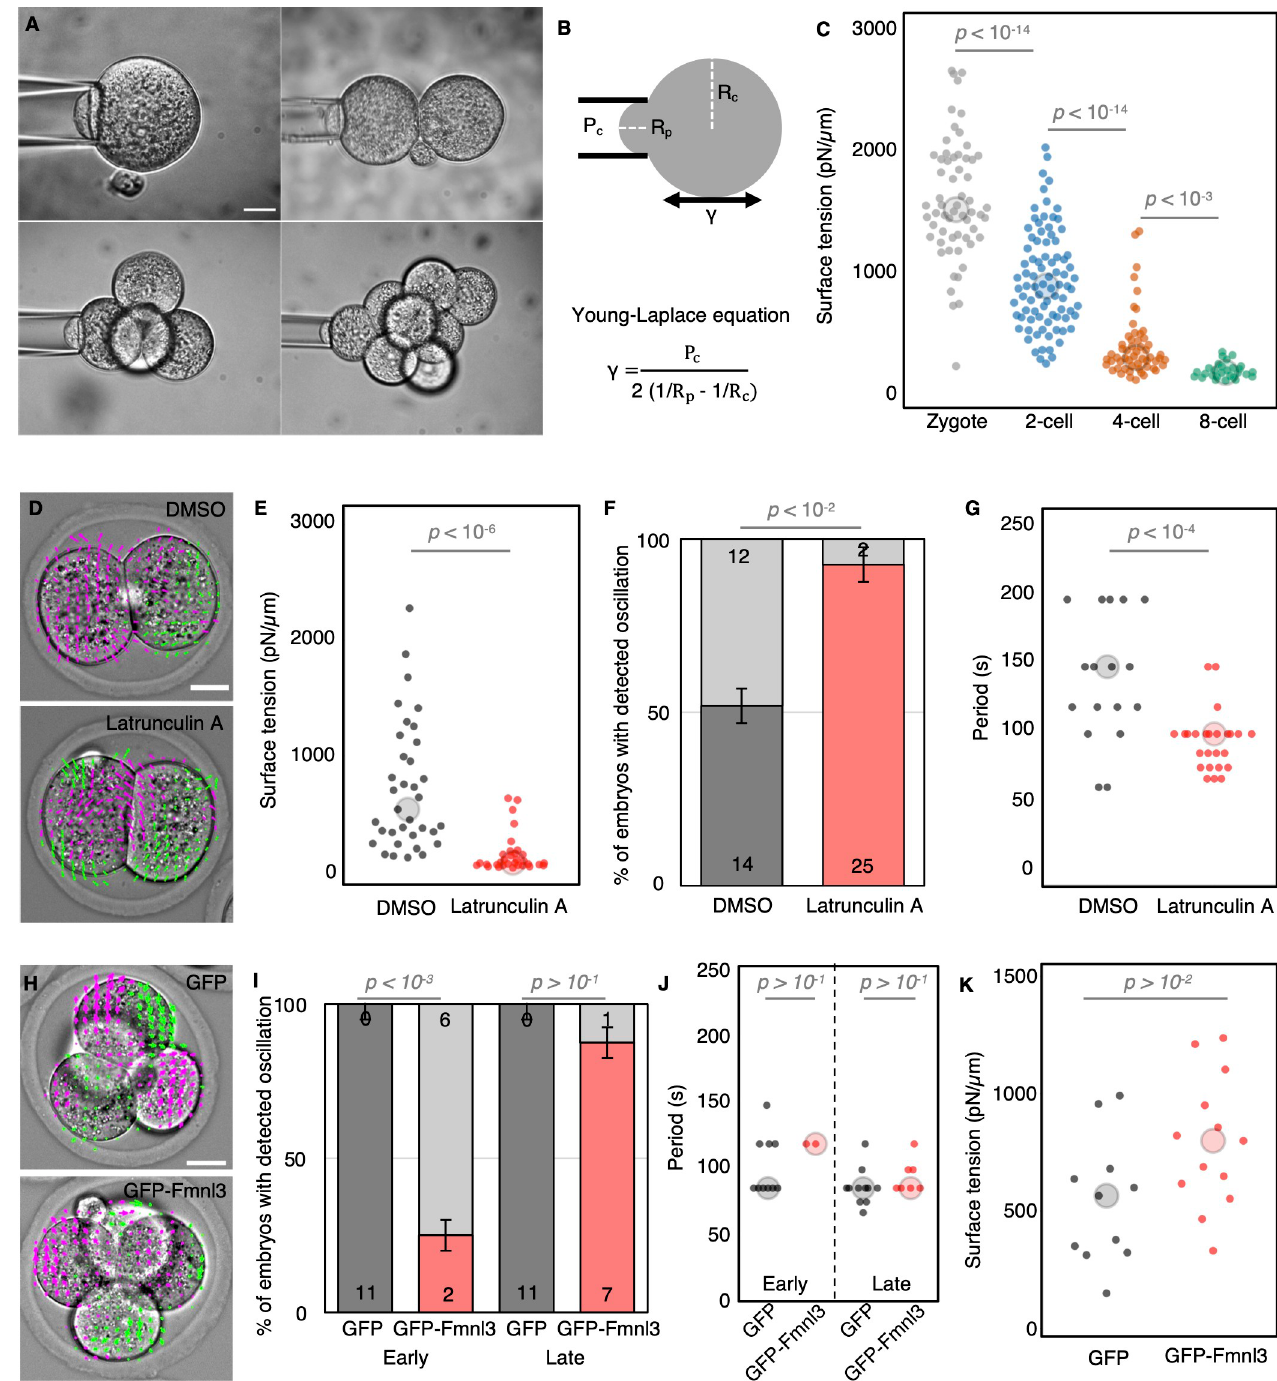
Fig 4. Cortical softening elicits PeCoWaCo. (A) Representative images of tension measurements at the zygote, 2-, 4-, and 8-cell stages. Scale bar, 20 μ m. (B) Schematic diagram of the surface tension measurements. Using the Young–Laplace equation, the surface tension γ can be calculated from the critical pressure P c applied by a micropipette of radius R p onto a cell of radius of curvature R c . (C) Surface tension of blastomeres throughout cleavage stages. Zygote (gray, n = 60), 2-cell (blue, n = 86), 4-cell (orange, n = 55), and early 8-cell (green, n = 28) stages are shown. Student t test p -values are indicated (S7 Table, S1 Data). (D) Representative images of Control and 100 nM Latrunculin A treated embryos overlaid with a subset of velocity vectors from PIV analysis (S8 Movie). Scale bar, 20 μ m. (E) Surface tension of embryos treated with DMSO ( n = 35) or 100 nM Latrunculin A ( n = 32). Student t test p -value is indicated (S7 Table, S1 Data). Larger circles show median values. (F, G) Proportion (F) of embryos showing detectable oscillations and their detected period (G) of DMSO treated ( n = 27) and 100 nM Latrunculin A treated ( n = 27) 2-cell stage embryos. Error bars show SEM. Chi-squared (F) and Student t test (G) p -values comparing 2